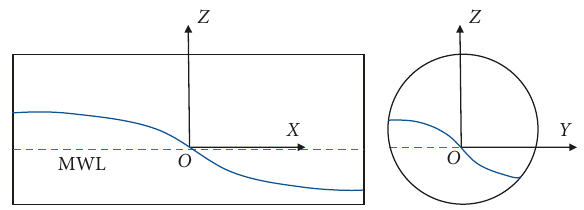
Figure 1: Coordinate system of linear sloshing